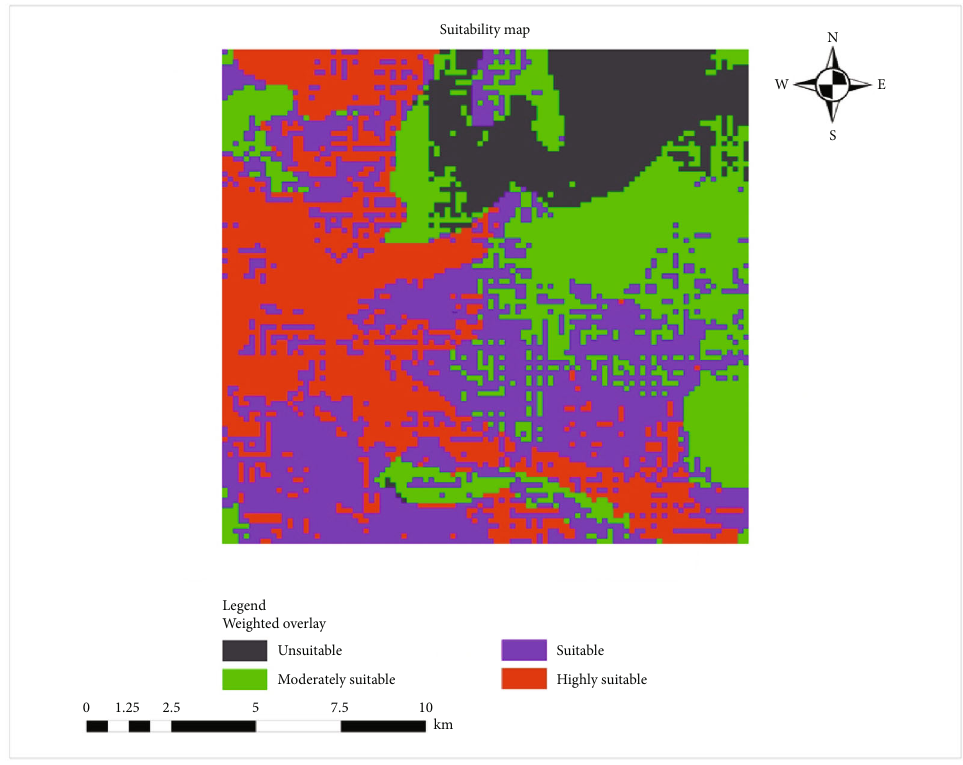
Figure 12: Suitability map with one percent